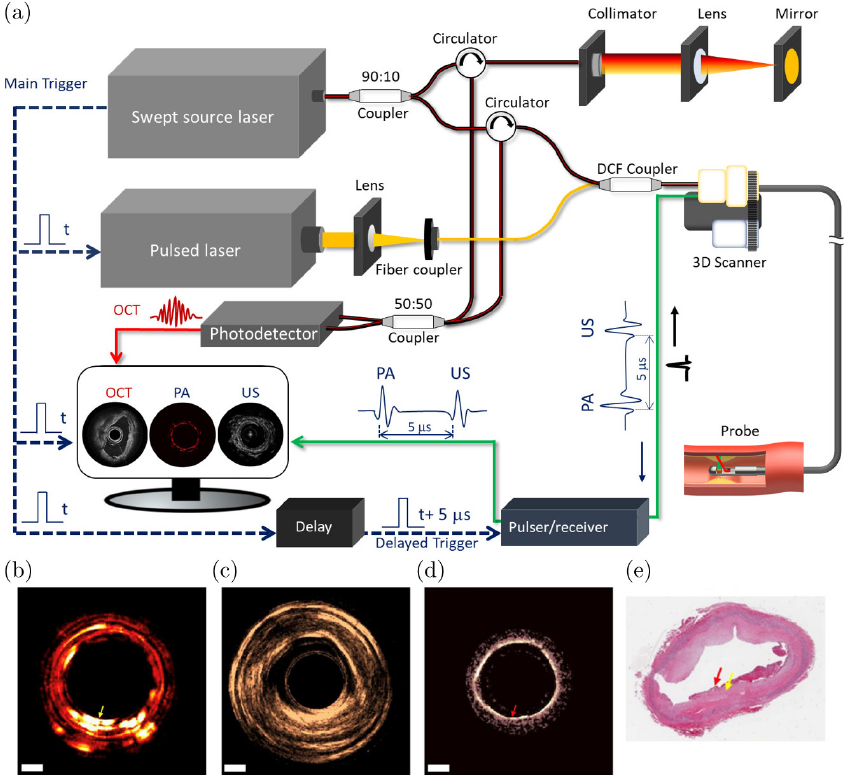
Fig. 6. Integrated IVOCT-PA-US of human artery. (a) System schematic. DCF: double-clad ¯ber. (b) PA image. (c) US image. (d) OCT image. (e) Histology. Scale bars: 2 mm. Adapted from Ref.